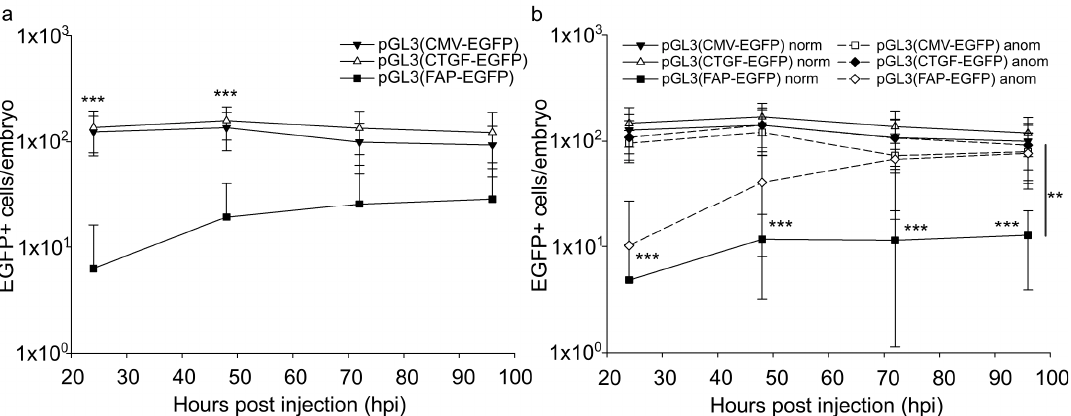
Figure 3. EGFP-positive cells in Danio rerio embryos after injection of 30 attomoles of pGL3(CMV-EGFP), pGL3(CTGF-EGFP), or pGL3(FAP-EGFP). The total number of EGFP-positive cells per animal. ( a ) EGFP+ cells in all injected embryos, logarithmic scale. Significant differences in the luciferase activity after the injection of pGL3(CMV-EGFP) and pGL3(CTGF-EGFP) relative to vector pGL3(FAP-EGFP) were observed from 24 to 48 h after injection ( p < 0.001). ( b ) EGFP+ cells in normal (full lines) and abnormal (dashed lines) injected embryos, logarithmic scale. Abscissa, hours after injection. Significant differences in the number of EGFP-positive cells in normal embryos after the injection of pGL3(CMV-EGFP) and pGL3(CTGF-EGFP) relative to vector pGL3(FAP-EGFP) were observed from 24 to 96 h after injection ( p < 0.001). The significance of differences in the number of EGFP-positive cells in abnormal embryos was observed 24 h after the injection of pGL3(CMV-EGFP) and pGL3(CTGF-EGFP) relative to vector pGL3(FAP-EGFP) ( p < 0.001). The significance of differences in the number of EGFP-positive cells in abnormal embryos relative to the one in normal embryos 96 h after the injection of pGL3(FAP-EGFP) were p < 0.01. The values were averaged for three independent experiments ( n = 72 for pGL3(CMV-EGFP), n = 78 pGL3(CTGF-EGFP), n = 113 for pGL3(FAP-EGFP)). Error bars indicate standard deviation (SD), ** p < 0.01, *** p < 0.001. Such embryos demonstrated different developmental abnormalities and